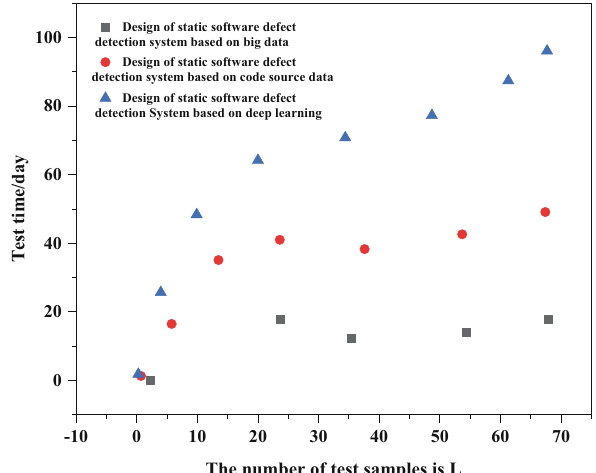
Figure 7: Comparison of time required for